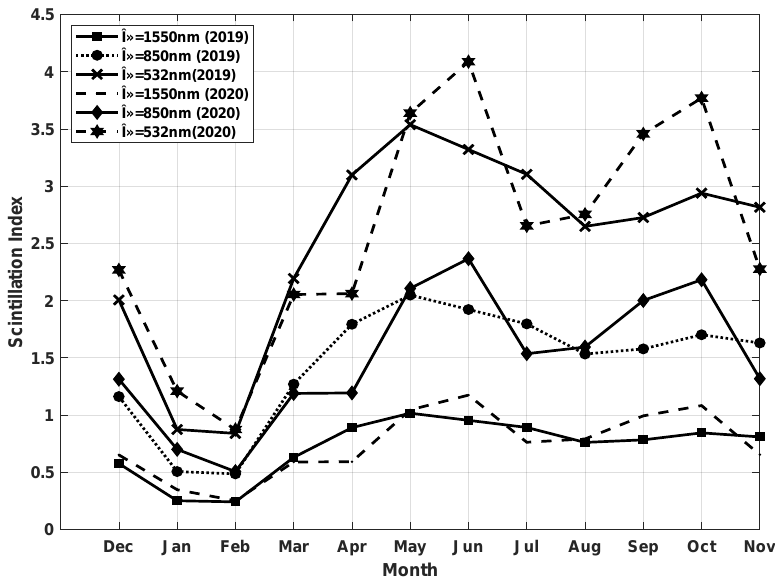
Figure 6. Comparison of Scintillation Index for Different Wavelengths at L = 1000 m.